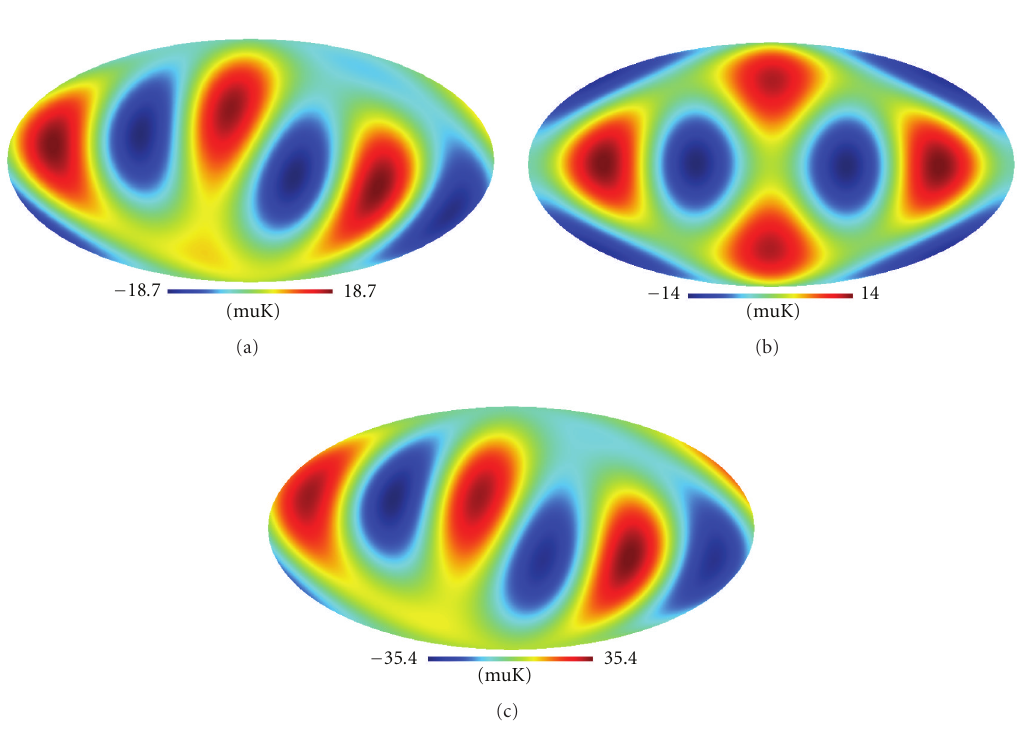
Figure 14: The octupole components of the WMAP7 ILC map (a), T + 3 ( θ , φ ) (b), and T − 3 ( θ , φ )